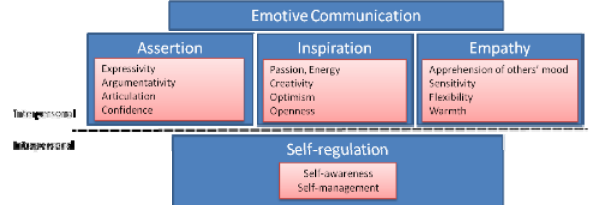
Figure 2. Emotive communication ability as part of the professional engineering skills